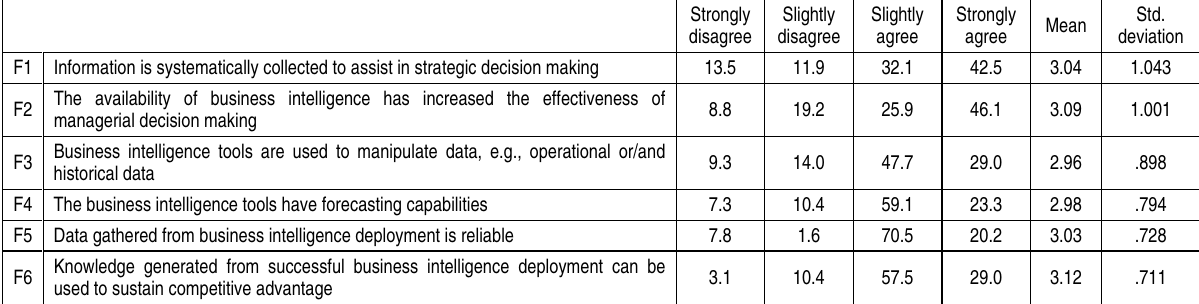
Table 1. Results of the questionnaire on business intelligence